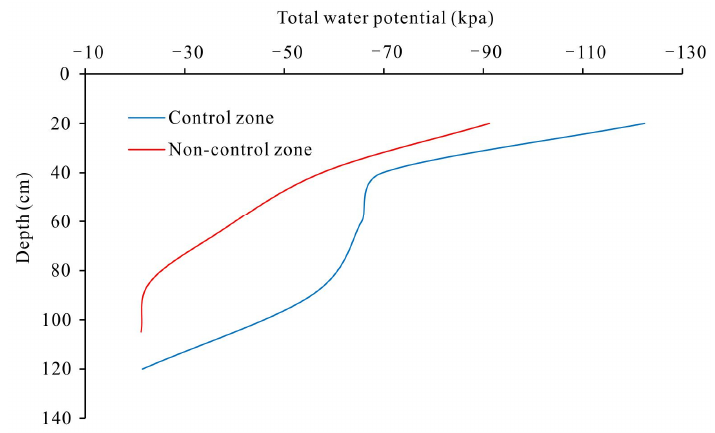
Figure 9. The total water potential at different depths along the monitoring profiles in the control and non-control zones. Table 1. Soil moisture content and its variable quantity at di ff erent depths in the control and non- control zones 2 days and 10 days after irrigation (unit: %).